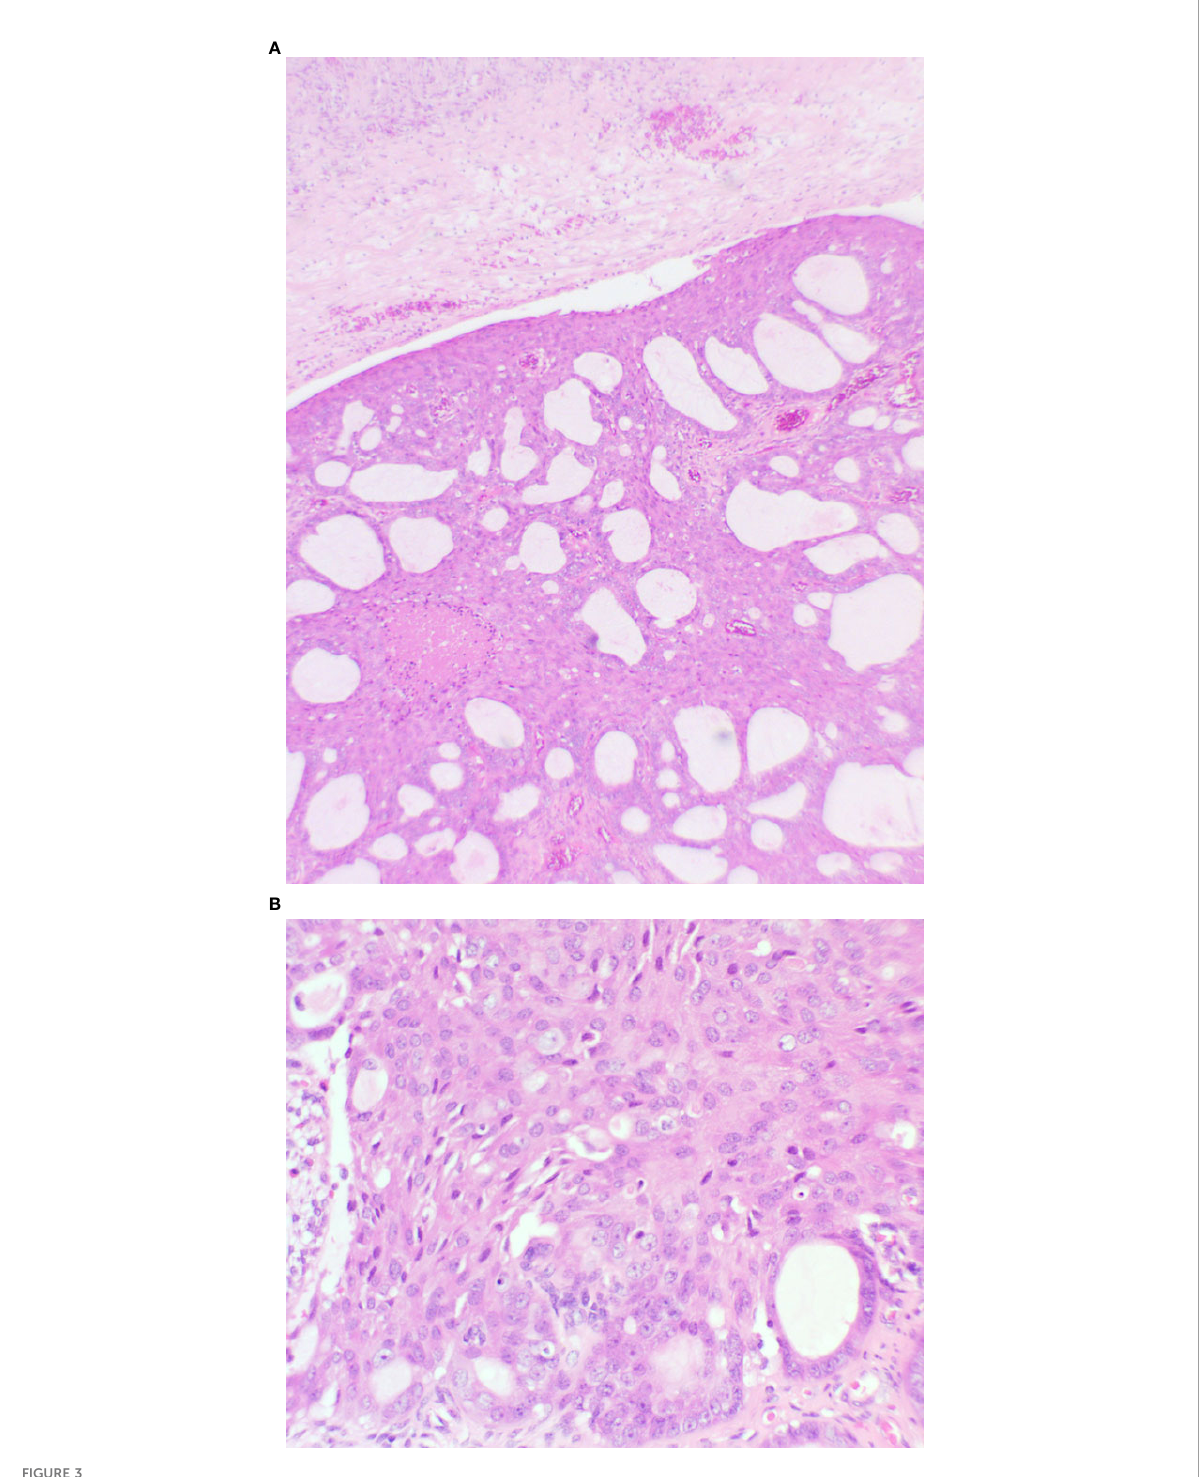
FIGURE 3 Ovary showing replacement by variably sized glands (A) : x20 magni fi cation, and solid areas (B) : x40 magni fi cation. The glands are lined by endometrioid type epithelium with cytological atypia. Necrosis is